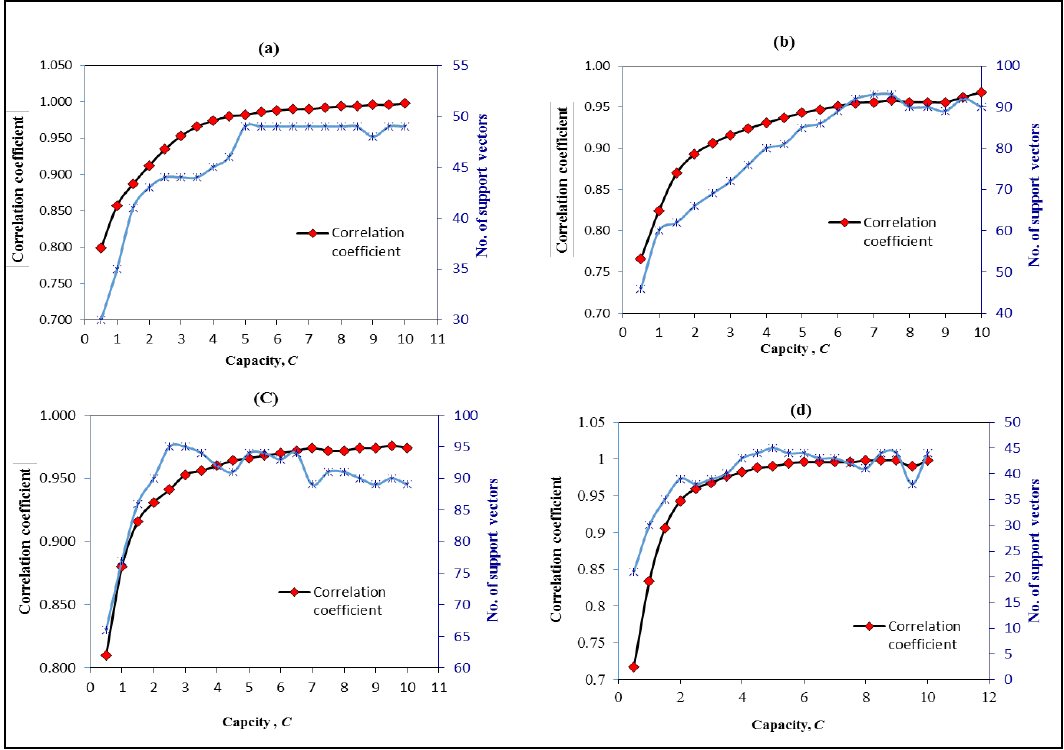
Figure 3. The result of various capacity parameter C , of SVM model, for ( a ) station 1; ( b ) station 2; ( c ) station 3; and ( d ) station 4.